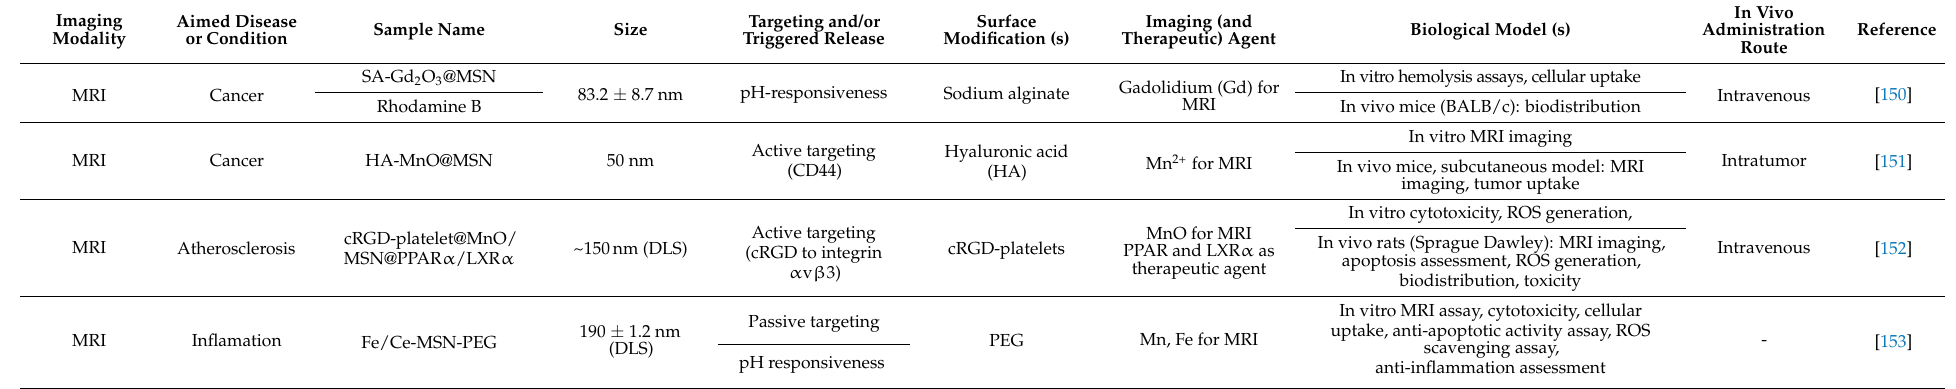
Table 2. Selected recent examples of MSNs developed as biomedical imaging or theranostic agents and evaluated in biological models. Sample names used by the authors are included, since, in some cases, they provided information about the composition of the nanocarrier. MSN: Mesoporous Silica Nanoparticle. MRI: Magnetic Resonance Imaging. NA: Not Available PEG: PolyEthylene Glycol. PET: Positron Emission Tomography. SPECT: Single-Photon Emission Computed Tomography. CT: Computerized